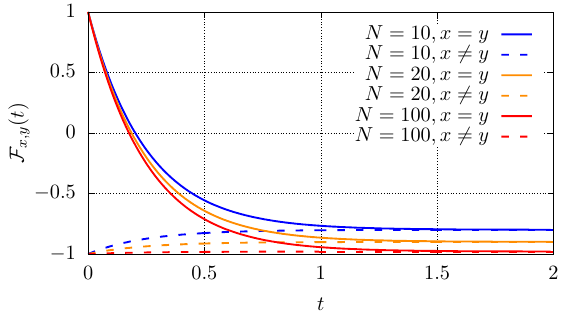
Figure 11 . OTOCs